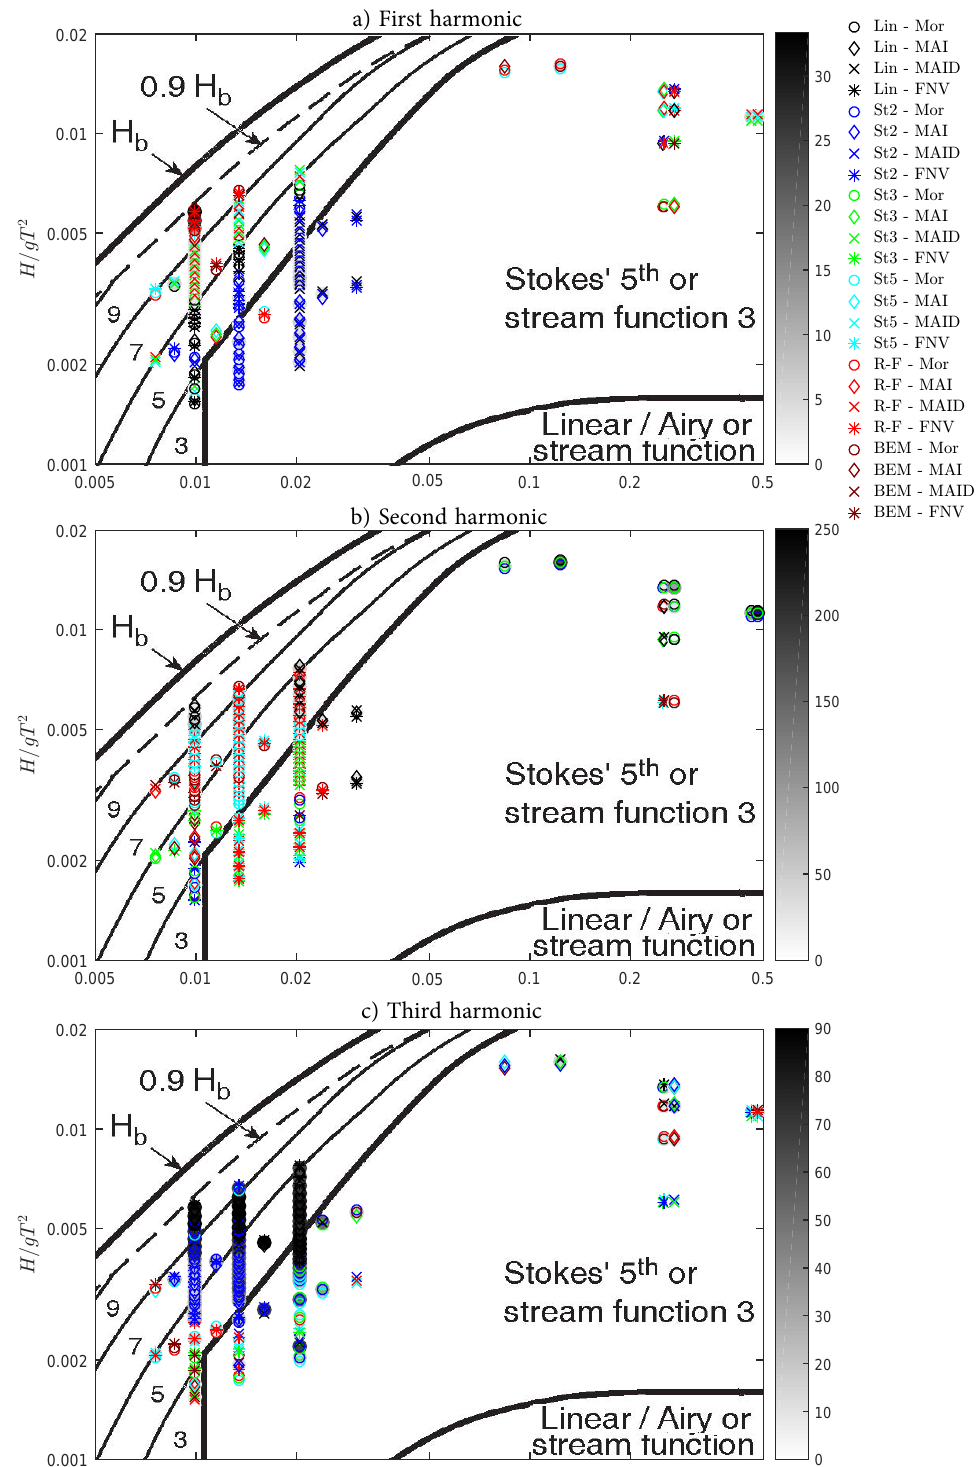
Figure 12. The three best-fitting numerical models for the first ( a ), second ( b ) and third ( c ) harmonics with the intensity behind the symbol referring to the relative error (the darker—the worse the error, scale dependent on the harmonic), displayed on the wave theory limit graph from [34]. H b stands for the breaking wave limit. Marker color denotes the wave kinematics, marker symbol—hydrodynamic loading model. For reference to experiments see Figure